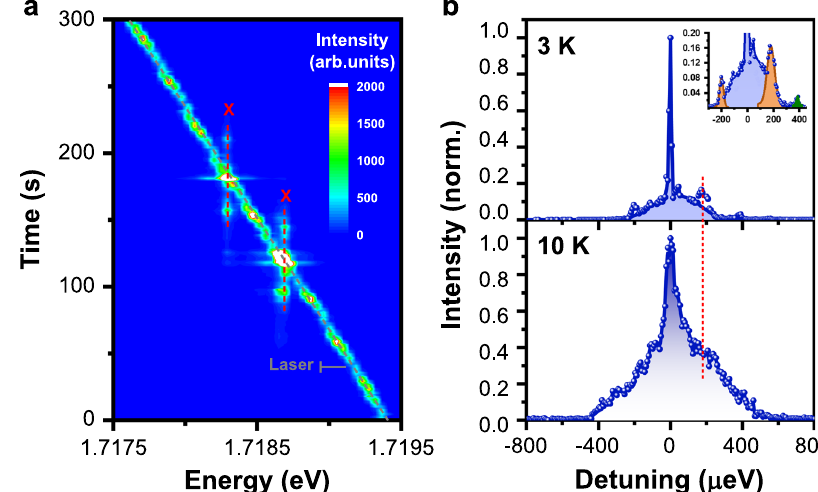
Fig. 3 Continuous acoustic phonons in a single CsPbI 3 NC. a 2D image showing intensity variations of the doublet PL peaks with the laser scanning energies from ~1.7175 – 1.7195 eV. Here X denotes the energy position for either of the doublet PL peaks. b (top panel) PL intensity of the lower-energy peak plotted as a function of the detuned laser energy at 3 K. Inset: Ampli fi ed view of the low-signal region. (bottom panel) PL intensity of the lower-energy peak plotted as a function of the detuned laser energy at 10 K. The dotted line marks the energy position where the phonon-assisted excitation ef fi ciencies of ~16.6 and ~37.1% can be achieved at 3 and 10 K, respectively, as compared to that of the resonant excitation at 0 µ eV. See Supplementary Fig. 6 and related discussions in the Supplementary Information for theoretical fi ts of the PL excitation spectra measured at 3 and 10